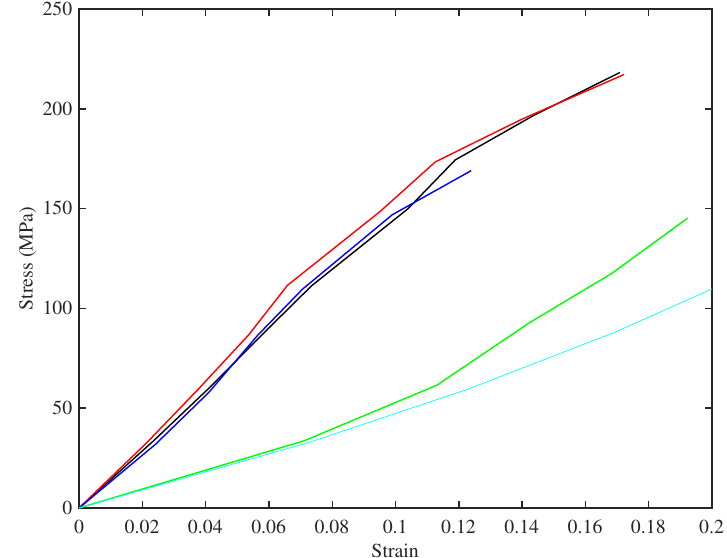
Figure 6. Long-term stress-strain plots at the base temperature of 20 ◦ C, with the strings settled at each point (using the creep-monitoring approach described in Section 3.4). Colours identify the di ff